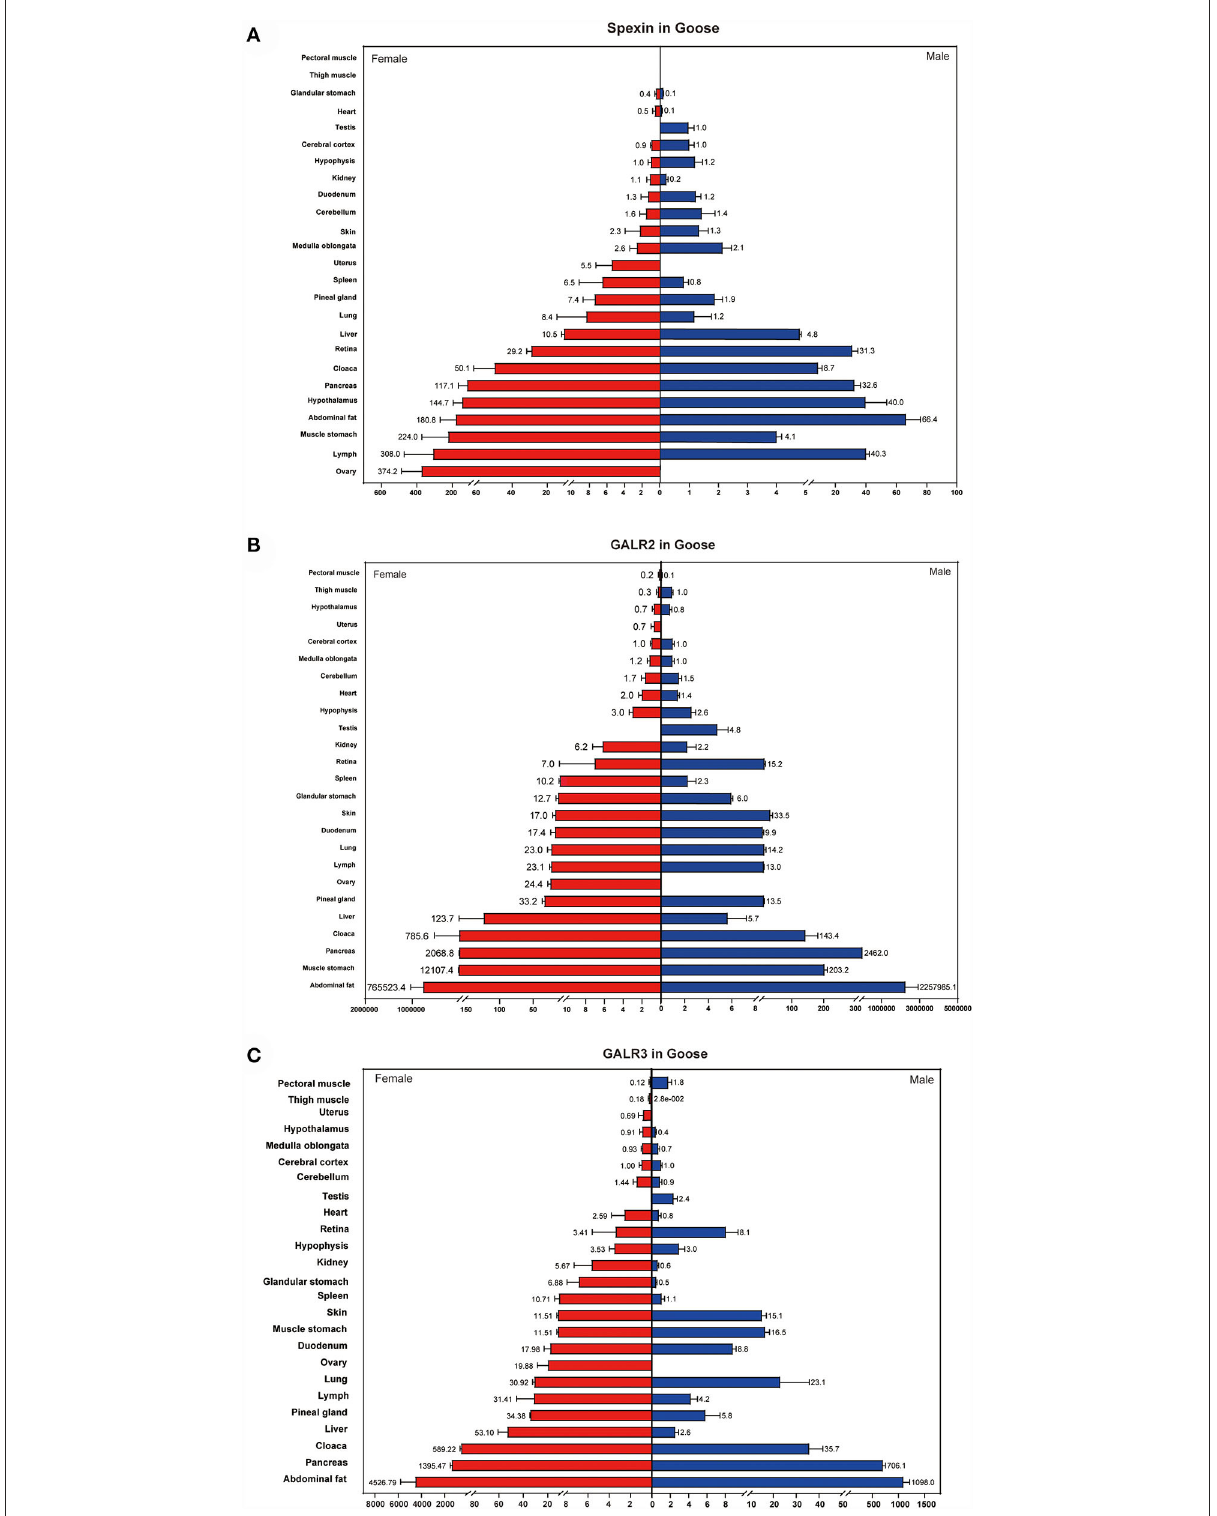
FIGURE3 Tissue distribution of spexin and GALR2/3 in female and male goose. (A) Tissue distribution of spexin in female and male goose. (B,C) Tissue distribution of GALR2/3 in female and male goose. The expression in cerebral cortex were used as a reference. Data are expressed as mean ± SEM ( n =